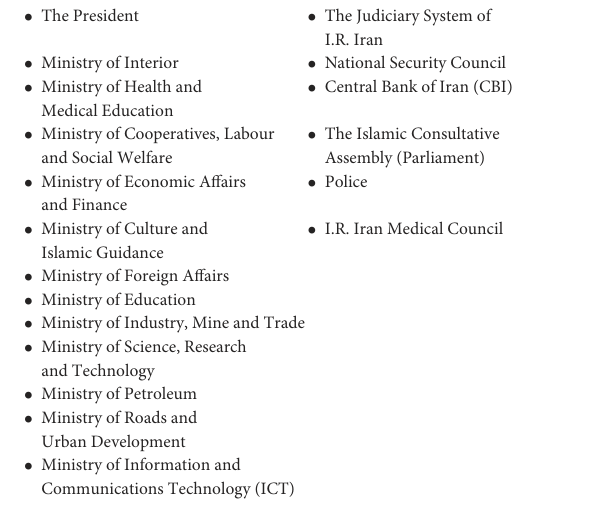
BOX 1 Illustrative example of ministries and sectors represented in the National Steering